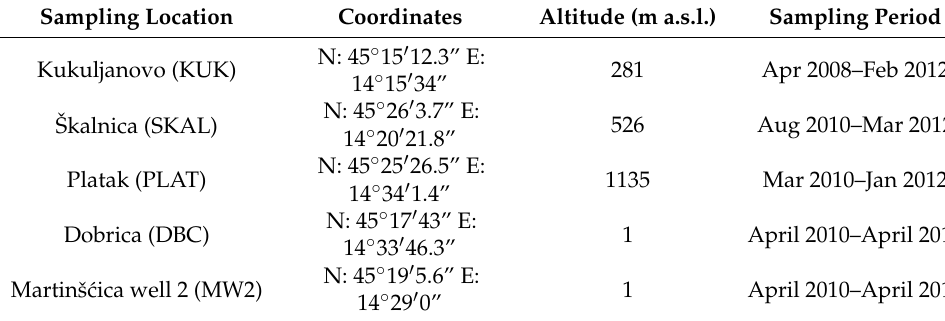
Table 1. Basic information about sampling locations. Sampling Location